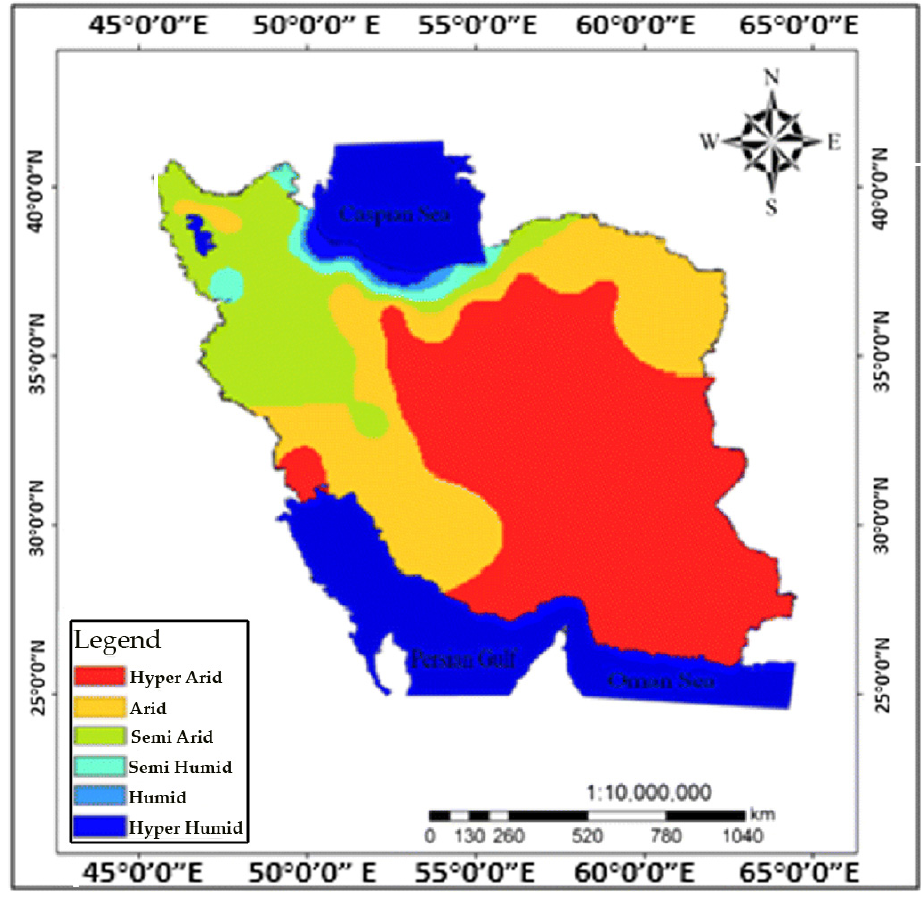
Figure 2. Iran aridity map (1981–2010).